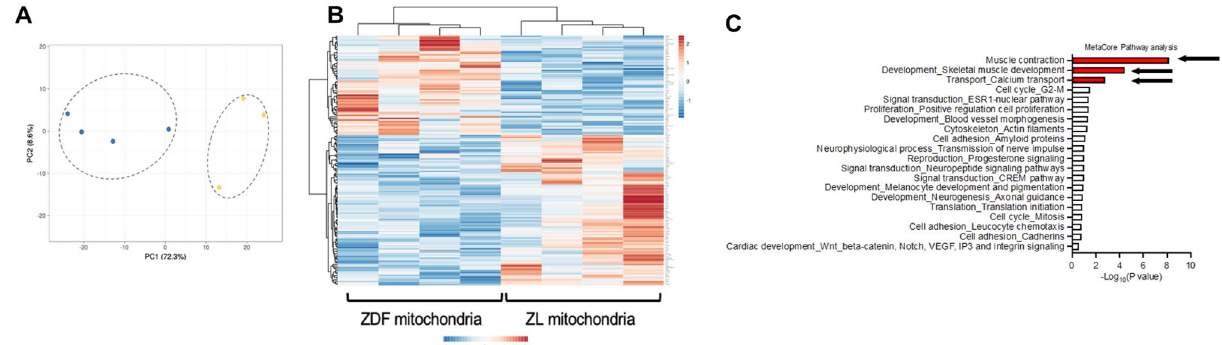
Figure 7. Transcriptomic pathways following 30 min of regional myocardial ischemia and 28 days recovery. ( A ) Principal component analysis (PCA) for hearts receiving diabetic ZDF- (gold circles) or non-diabetic ZL -mitochondrial transplantation (blue circles) as compared to hearts receiving vehicle alone. ( B ) Heatmap of transcriptional regulation patterns following 30 min of IRI and 28 days recovery for hearts receiving diabetic ZDF- (gold circles) or non-diabetic ZL -mitochondrial transplantation (blue circles). Fold changes (FC) are derived from comparison to Vehicle hearts. The log FC of gene expression is shown with pseudocolor scale (− 1 to 2), with blue denoting downregulation and orange denoting upregulation. Columns represent FC comparisons, and rows represent the genes. Experimental groups are found on the bottom. ( C ) Gene set